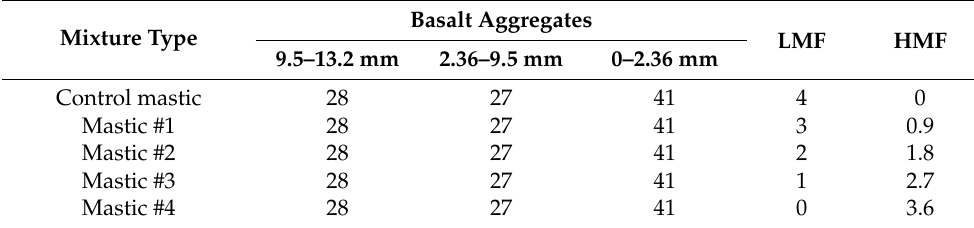
Table 3. Mass ratios of composition in asphalt mixture (% by weight).